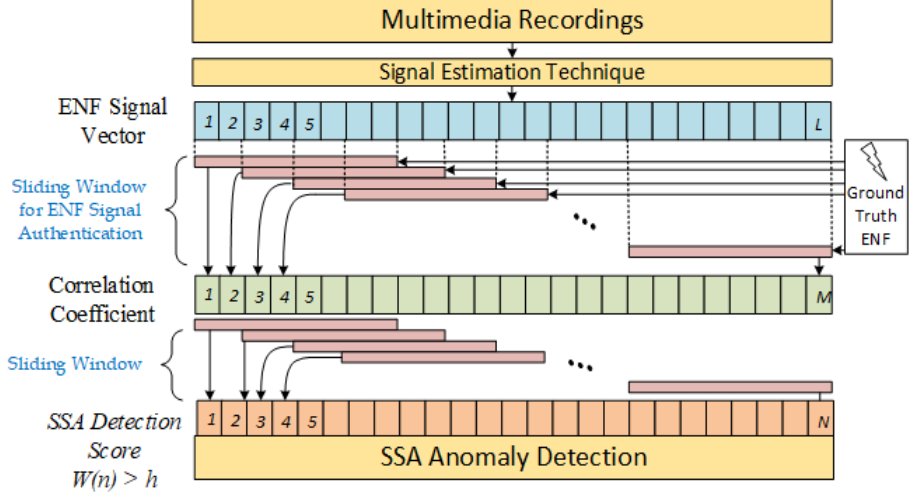
Figure 1. Singular Spectrum Analysis (SSA) algorithm using the ENF signal and its correlation